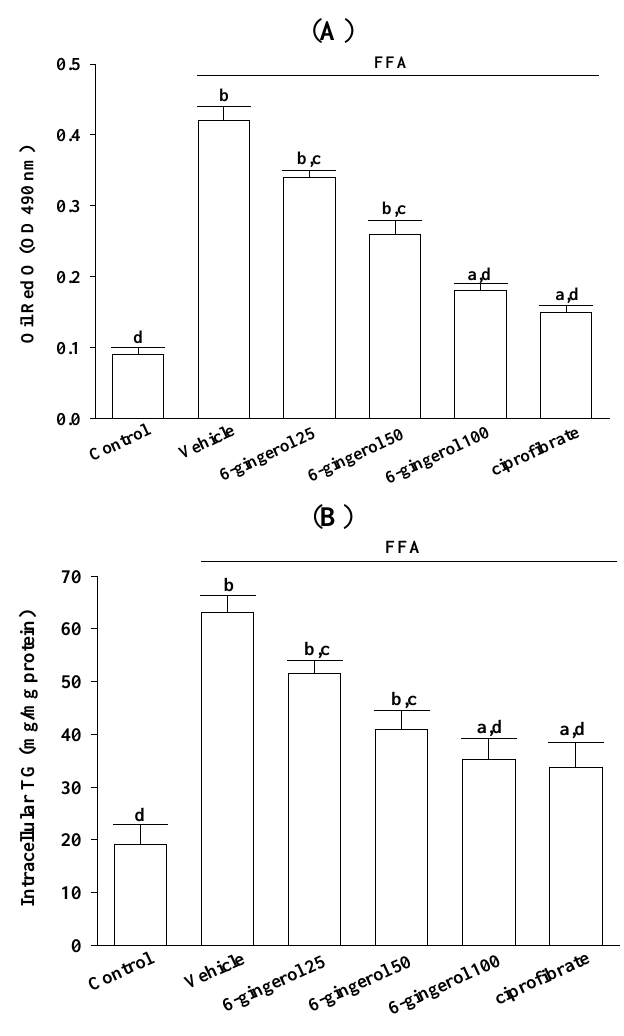
Figure 2. Effects of different treatments on FFAs mixture-induced cellular lipid accumulation in HepG2 cells. HepG2 cells were exposed to a FFAs mixture (0.33 mmol/L palmitate and 0.66 mmol/L oleate) for 24 h, and were then incubated for another 24 h with 6-gingerol at concentrations of 25 μmol/L (6-gingerol 25), 50 μmol/L (6-gingerol 50), or 100 μmol/L (6-gingerol 100), or with 100 μmol/L of ciprofibrate (ciprofibrate). The vehicle (distilled water) used to prepare the test medication solutions was given at the same volume. Cells supplemented with medium without any treatment served as the control. ( A ) Stained lipid droplets were analyzed by spectrophotometry; ( B ) Total intracellular TG contents determined by an enzymatic colorimetric method. a p < 0.05 and b p < 0.01 compared to untreated control results. c p < 0.05 and d p < 0.01 compared to results for FFAs mixture-treated